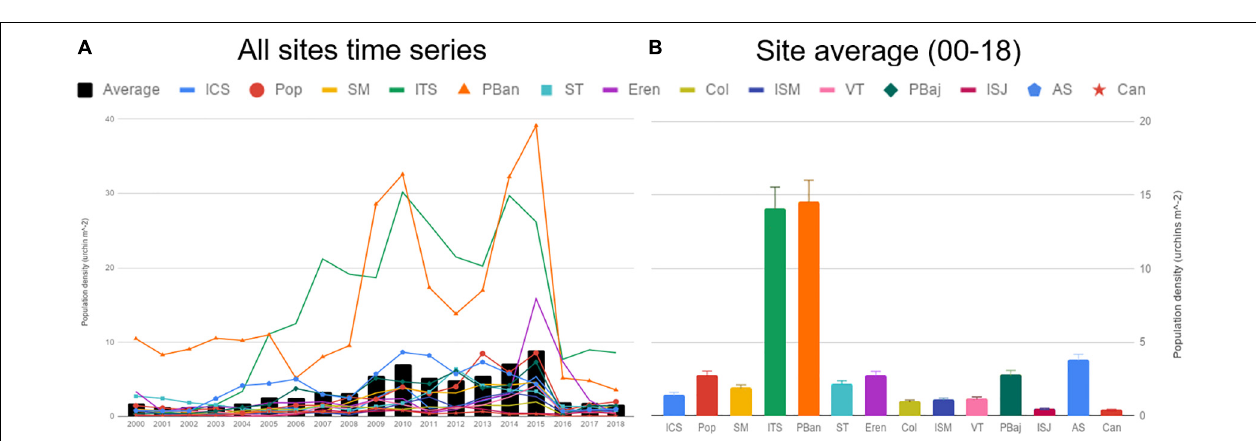
FIGURE 5 | Average population density estimates from 2000 to 2018 (A) , and 19-year site average (B)